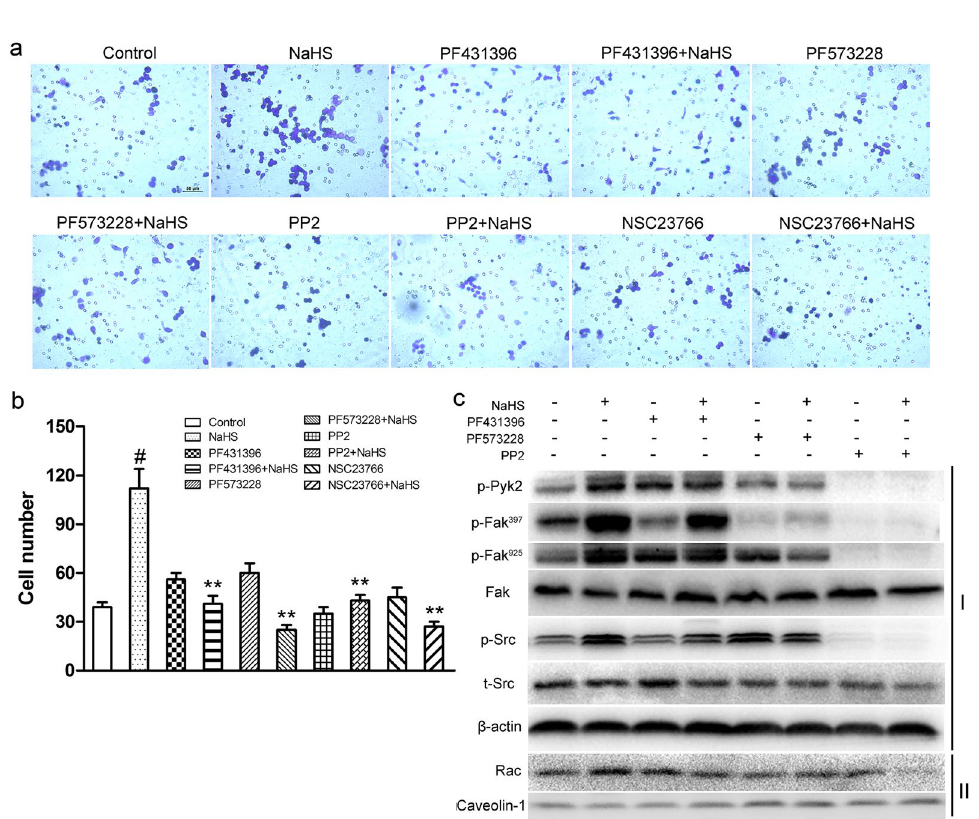
Figure 4. The Src-FAK/Pyk2-Rac pathway responded to macrophage migration triggered by NaHS. ( a ) RAW264.7 cells were incubated for 1 h in the presence or absence of PF431396 (5 μM), PF573228 (5 μM), PP2 (10 μM) or NSC23766 (25 μM) respectively, followed by incubation with additional 100 μM NaHS for 6 h. The migratory ability of RAW264.7 cells was determined by transwell assay. Scale bar, 50 μm. ( b ) The numbers of the migrated cells per field were shown as the mean ± SEM from three independent experiments. # P < 0.05 versus Control, ** P < 0.01 versus NaHS treatment. ( c ) RAW264.7 cells were incubated with PF431396 (5 μM), PF573228 (5 μM) or PP2 (10 μM) respectively for 1 h before 100 μM NaHS treatment. The expressions of indicated proteins were assessed by western blot (I, total cell lysates; II, membrane extracts; p, phosphorylated; t,